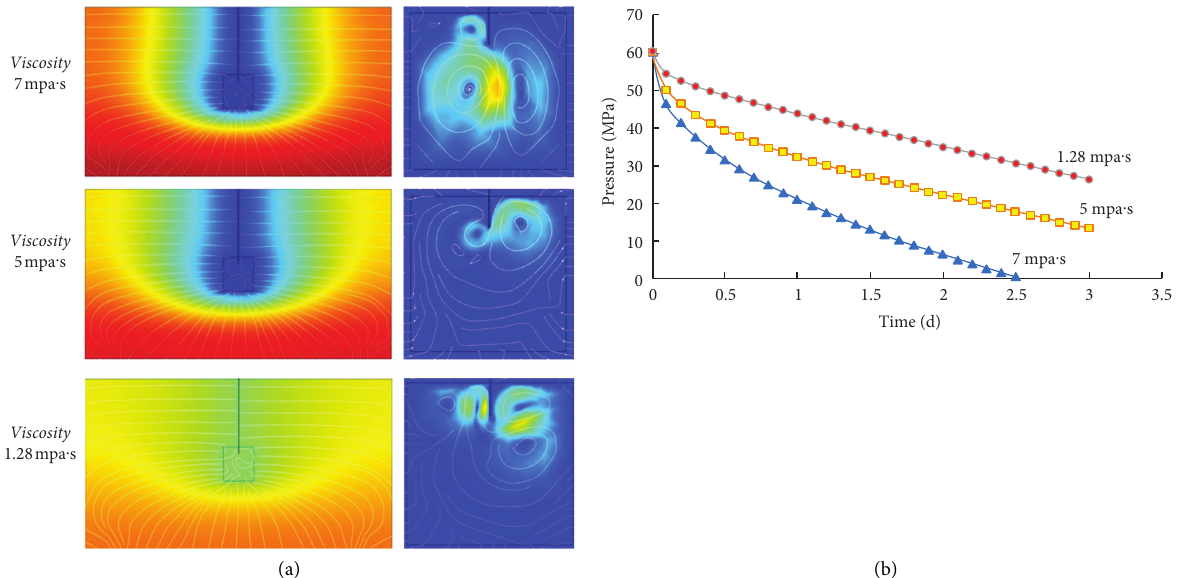
Figure 11: Distribution of pressure and velocity fields with different dynamic viscosity (a) and pressure comparison of different dynamic viscosity